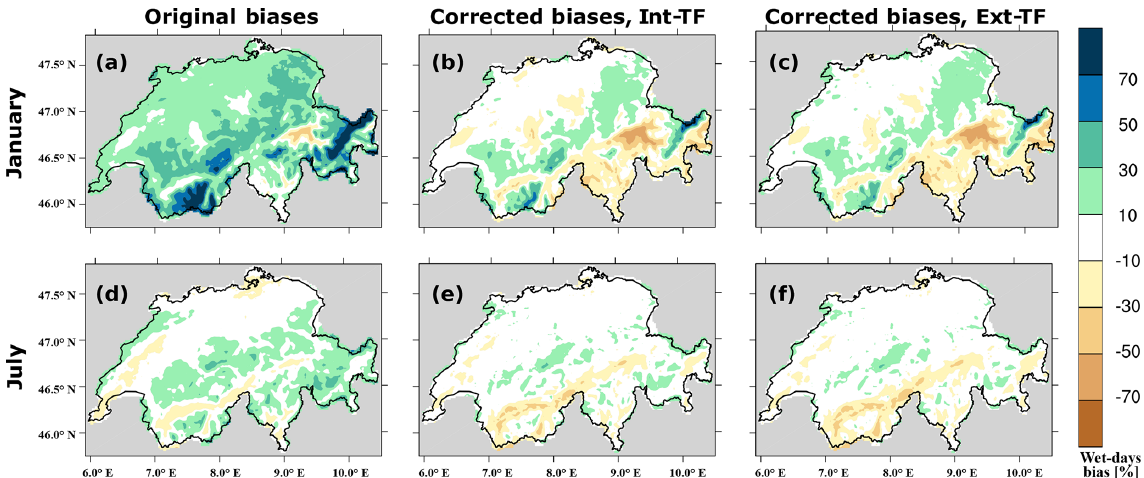
Figure 9. Biases in the wet-day frequency within the 30-year period over Switzerland. Panel (a) represents the original biases in January, (b) the biases after being corrected using Int-TFs in January, and (c) the biases after being corrected using Ext-TFs in January; panels (d) , (e) , and (f) are the same as (a) , (b) , and (c) but in July,